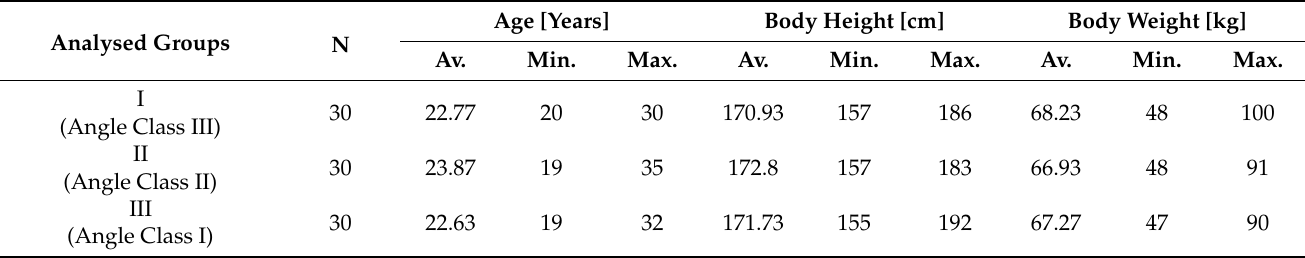
Table 1. Characteristics of the analysed groups, including people with Angle Class I, II and III.